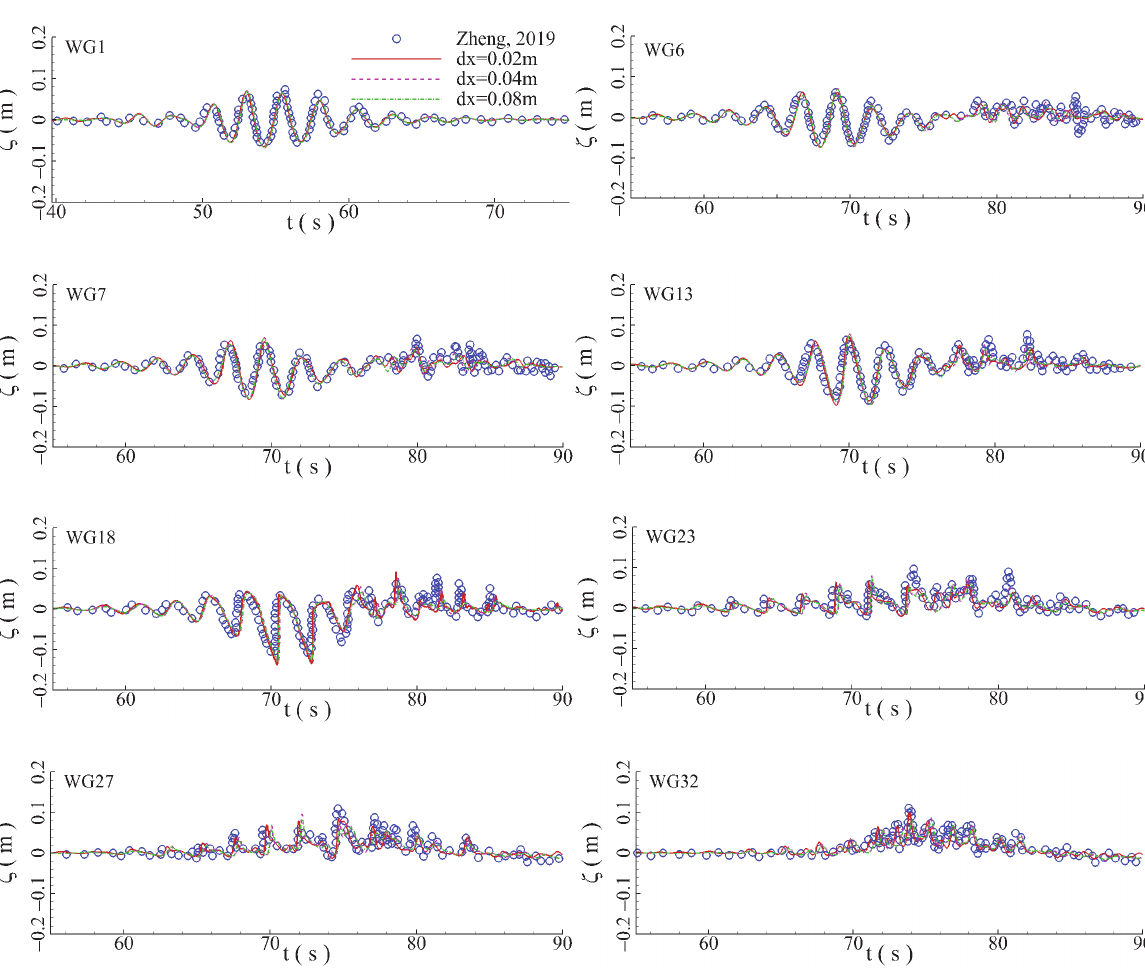
Figure 3. Experimental layout.